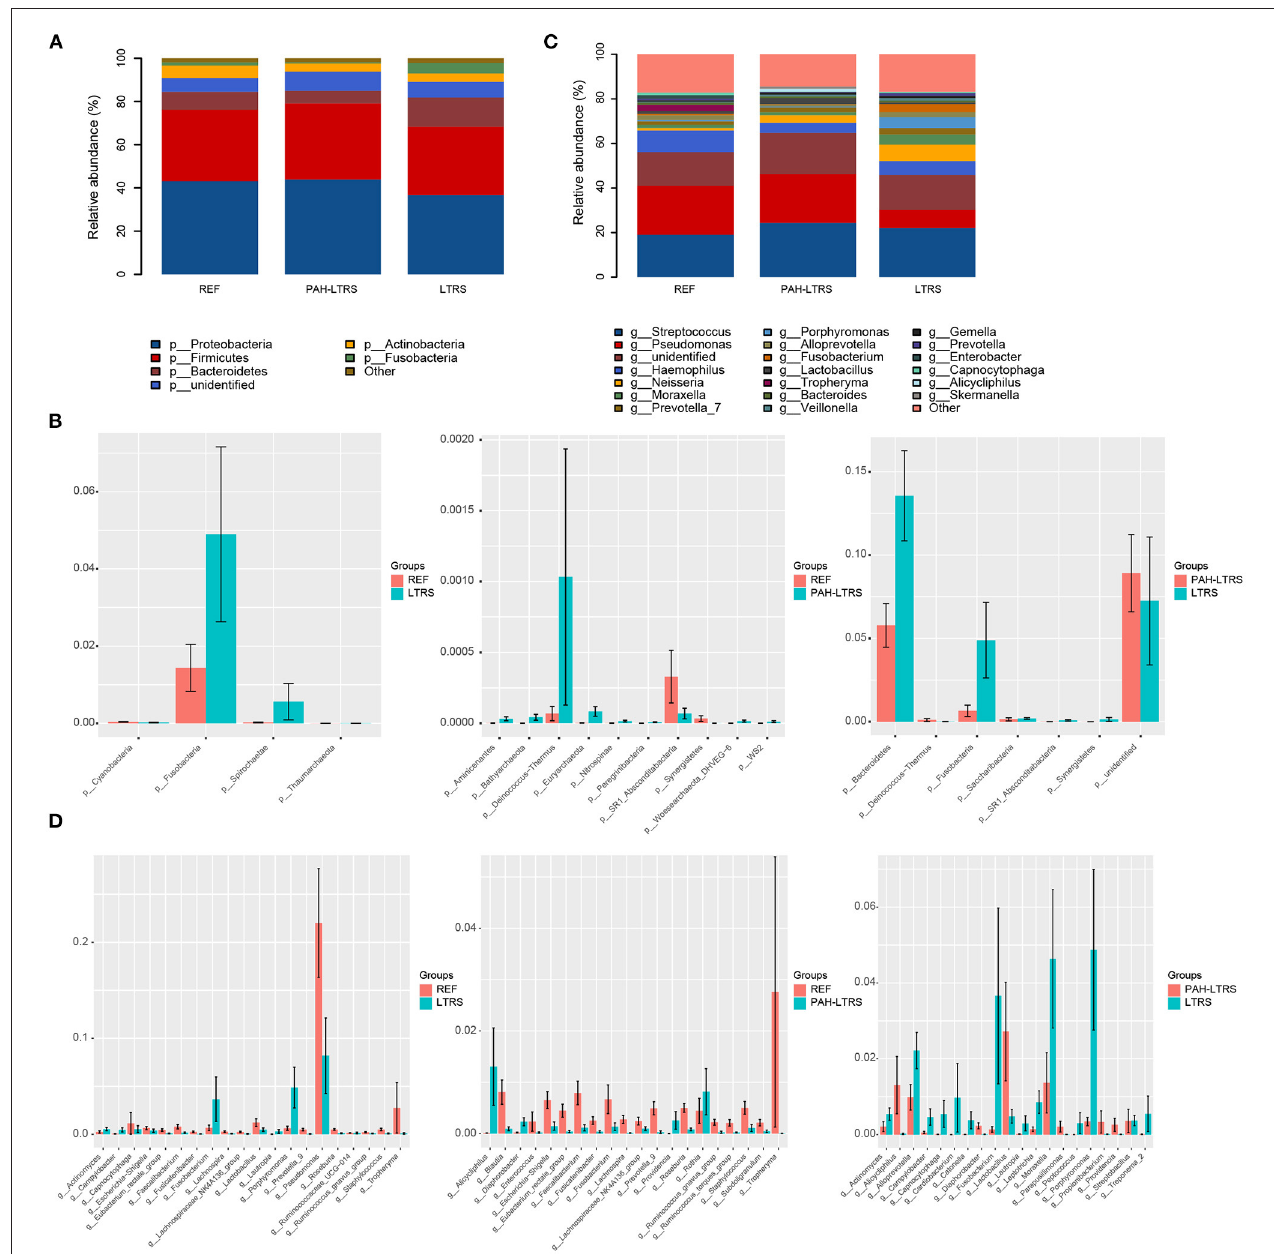
FIGURE 2 | Taxonomic composition of the lung microbiota among three cohorts. (A) The relative frequency of top abundant taxa in each cohort at the phylum level. (B) The relative abundance analysis of top altered phylum in three pair of comparisons (means ± s.e.m.). (C) The relative frequency of top abundant taxa in each cohort at the genus level. (D) Analysis of the relative abundance of top fluctuated genera between any two different cohorts (means ± s.e.m.). Wilcoxon rank sum test, p < 0.05. PAH-LTRS, patients with pulmonary arterial hypertension associated with Left-to-Right shunt ( n = 15); REF, healthy reference ( n = 16); LTRS, patients with Left-to-Right shunts but without PAH ( n =